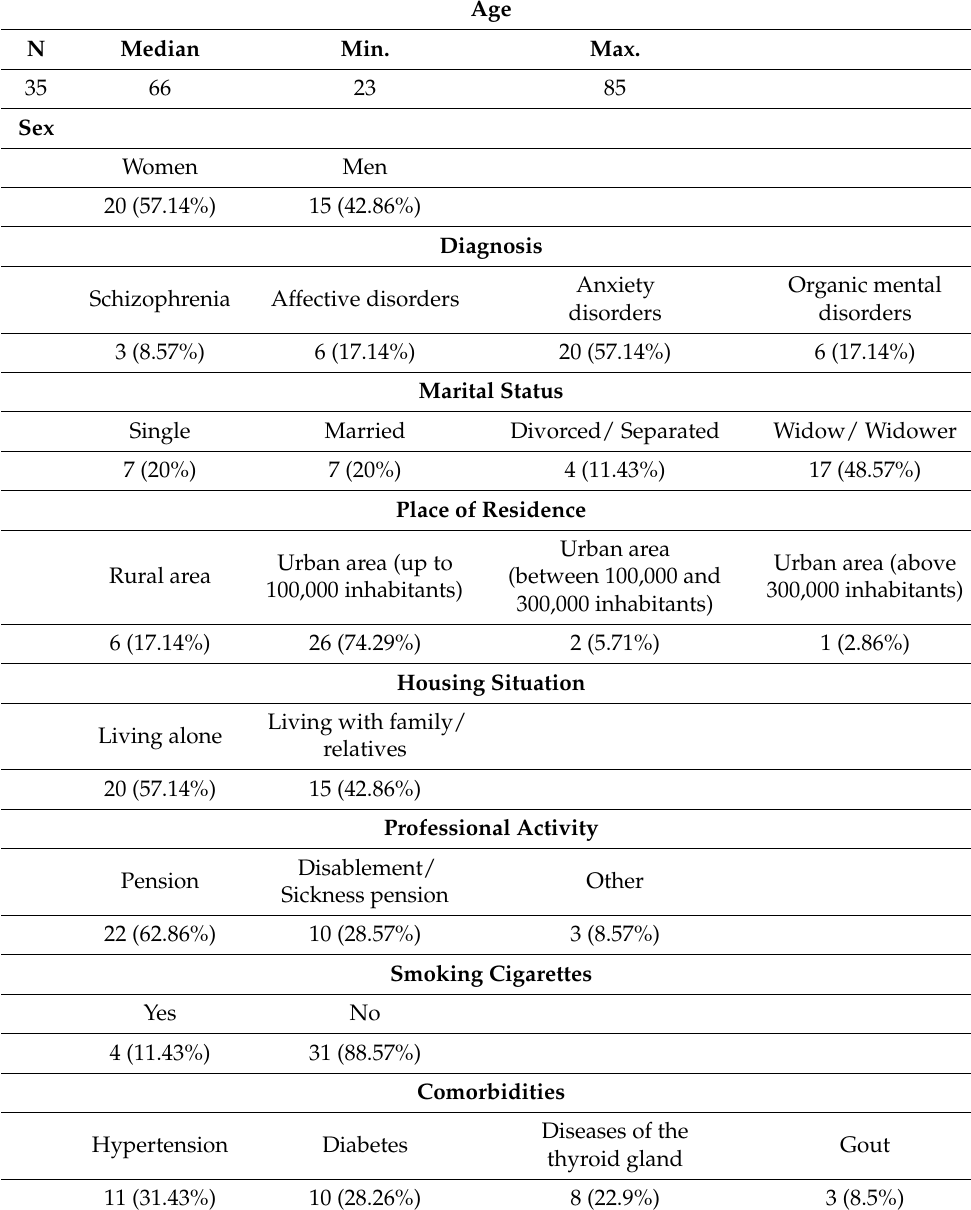
Table 1. Study group characteristics.